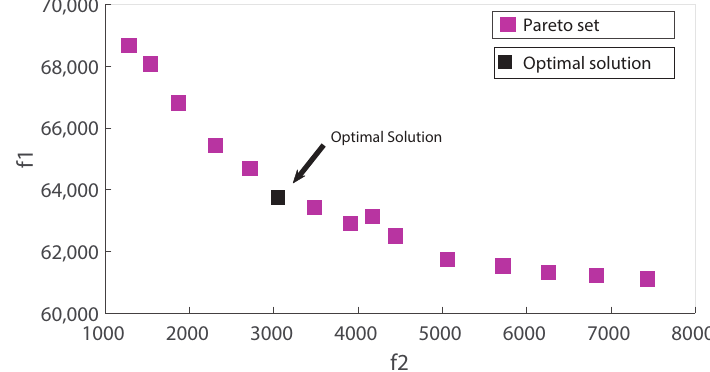
Figure 5. Simultaneous optimization of ( F 1, F 2).